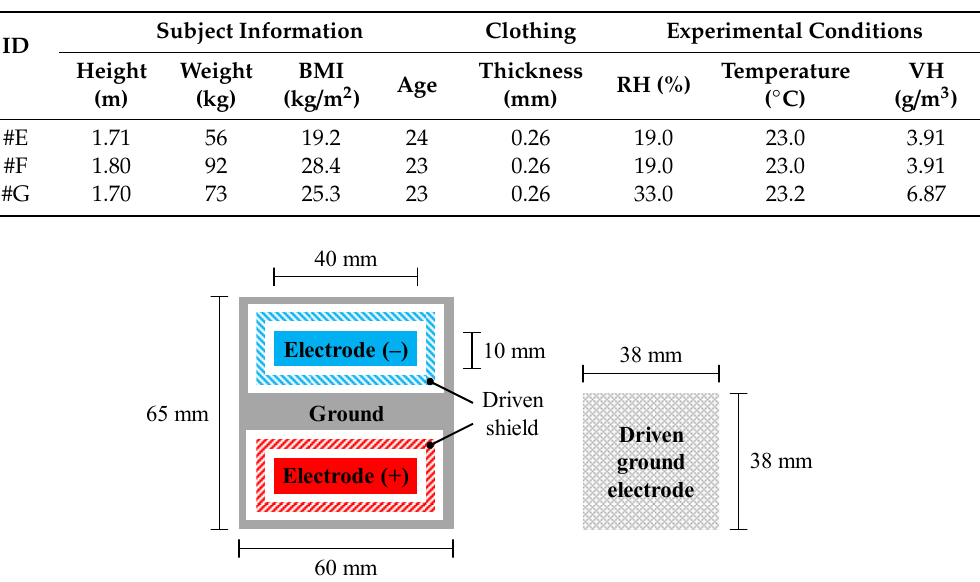
Figure 5. Top view configuration of flexible pad electrode ( left ) and driven ground electrode (DGE, right ) employed for cEMG measurement. The pad electrode has a five-layered structure. DGE is used for the negative feedback of a voltage synthesized from two voltages that were independently obtained with negative and positive electrodes in the pad.